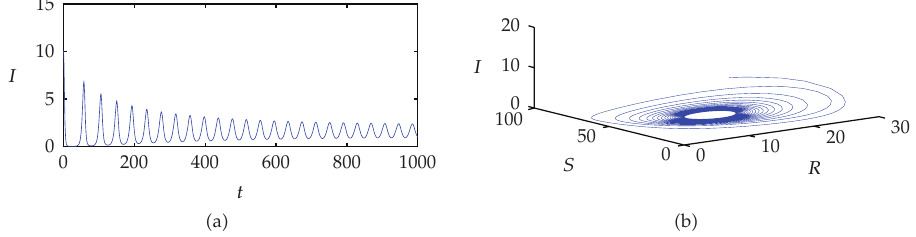
Figure 4: Temporal behavior of the infected and corresponding three-dimensional phase are plotted for the system (cid:2) 1.1 (cid:3) subject to 1 < R c < R 0 < R cc (cid:2) R c (cid:8) 2 . 23, R 0 (cid:8) 2 . 40, R cc (cid:8) 2 . 6 (cid:3) . The parameters are r (cid:8) 0 . 1, K (cid:8) 80, β (cid:8) 0 . 1, μ 1 (cid:8) 0 . 5, μ 2 (cid:8) 0 . 1, α (cid:8) 0 . 05, γ (cid:8) 0 . 75 , and τ (cid:8) 0 . 001 with initial value (cid:2) 35, 10, 15 (cid:3)